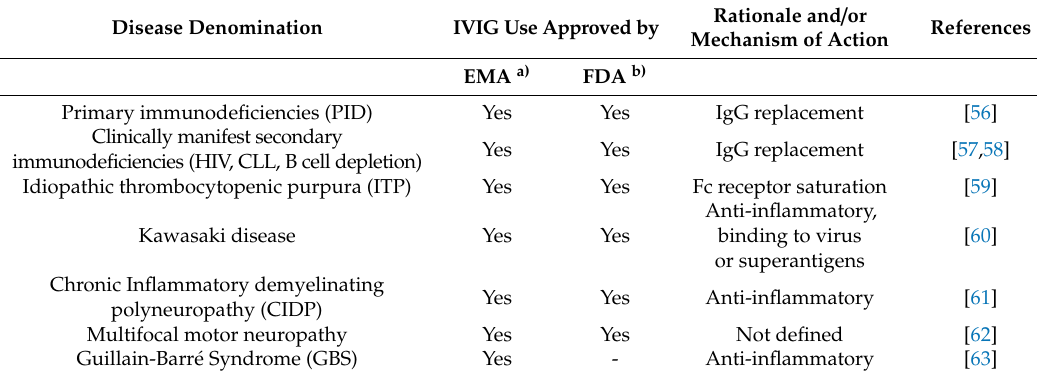
Table 1. List of diseases for which treatment with human normal immunoglobulin for intravenous administration (IVIG) has been approved by the Food and Drug Administration (FDA) and / or European Medicines Agency (EMA).